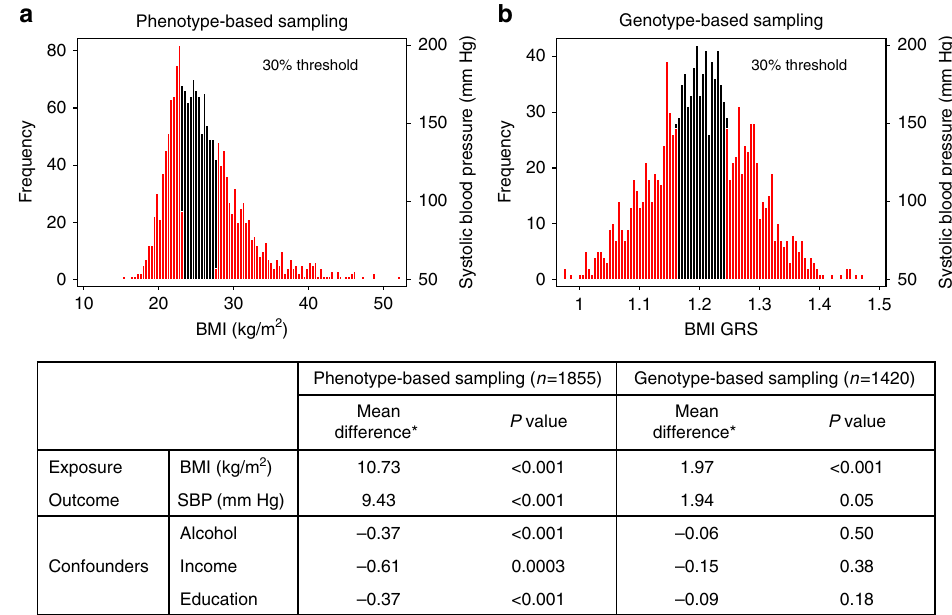
Fig. 2 Contrast between phenotype and genotype-based sampling strategies. Histograms show the distributions of a body mass index (BMI) and b the BMI genetic risk score (GRS) in the Avon Longitudinal Study of Parents and Children (ALSPAC). For a description of the ALSPAC data, please see Supplementary Note 2. Red bars represent the top and bottom 30% of these distributions. Mean differences in BMI, systolic blood pressure (SBP) and confounding factors (alcohol, income and education) were compared between the top and bottom 30% of the a BMI and b BMI GRS distribution. a For extreme-phenotype recall studies, participants at the extreme ends of the phenotypic distribution are invited to participate in the study. As an exemplar of this, phenotype data from 1855 individuals in ALSPAC was used. While differences in BMI and SBP are observed between the top and bottom 30% of the BMI distribution, extreme-phenotype sampling strategies are often prone to confounding and potential reverse causality (as shown by the association of the recalled strata with confounding factors). b In contrast, RbG studies have the ability to generate reliable gradients of biological difference in combination with essentially randomised groups. As an exemplar of this, genetic data from 1420 individuals in ALSPAC was used to generate a BMI GRS. Differences in BMI and SBP are observed between the top and bottom 30% of the BMI GRS distribution that are not prone to confounding and reverse causality (as shown by the lack of association of the recalled strata with confounding